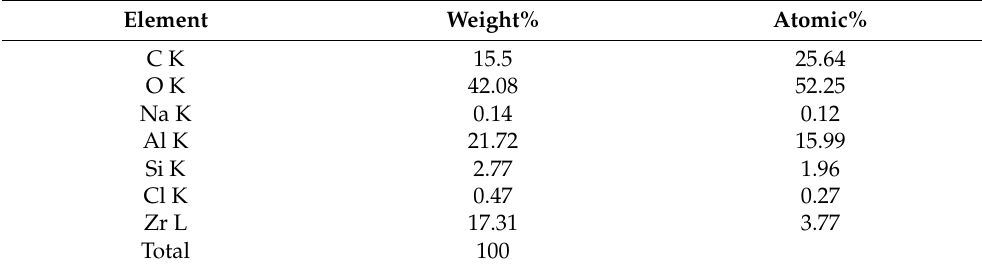
Table 3. The element composition of the fouled membrane.